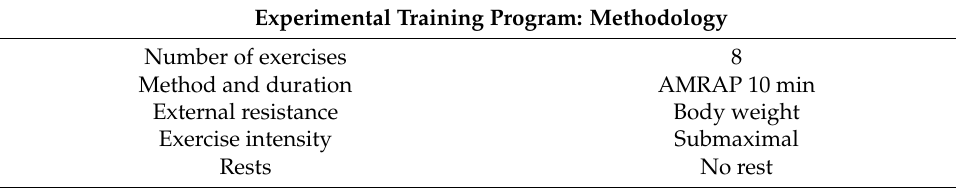
Table 1. Methodology of the experimental training program.